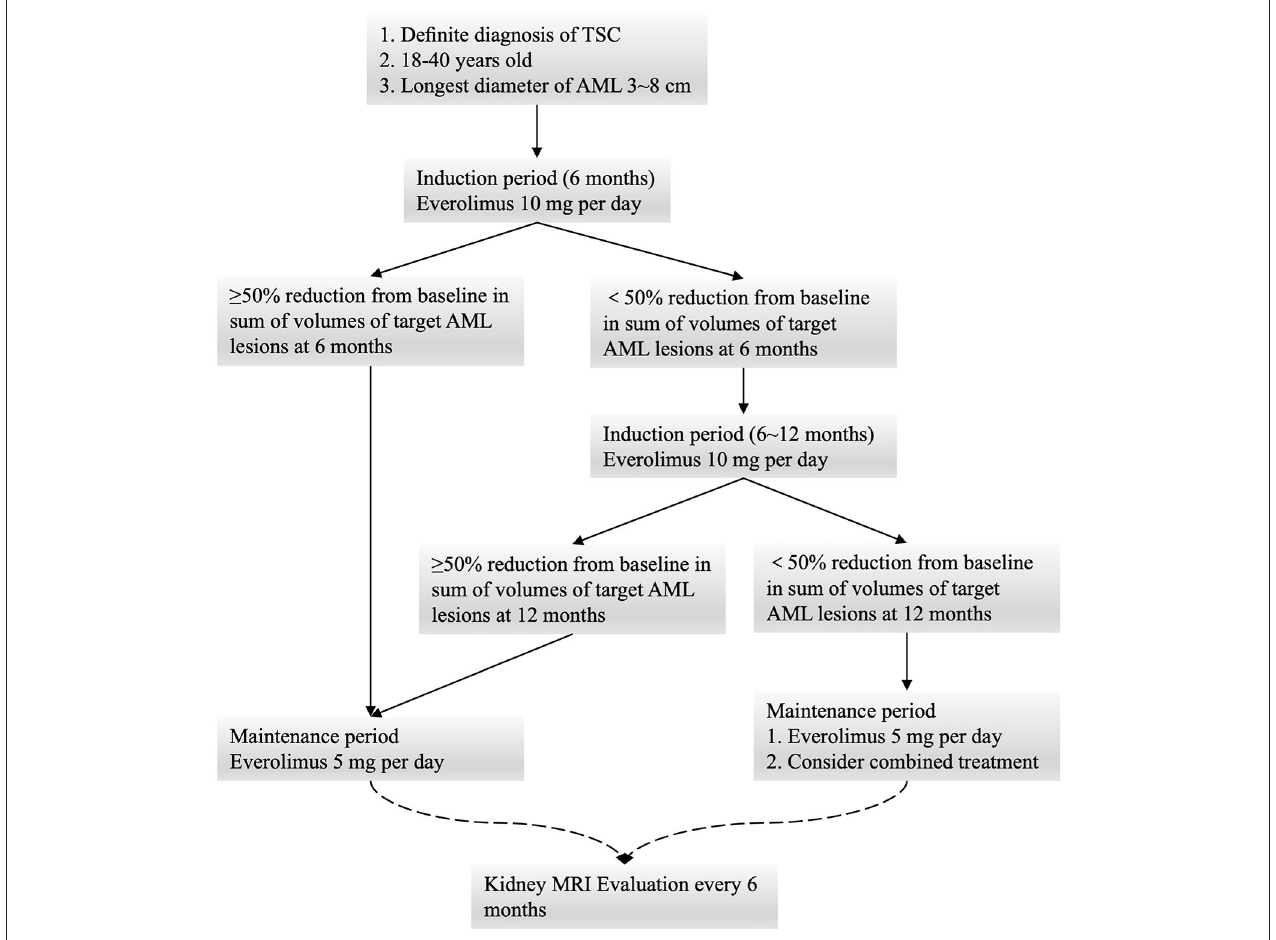
FIGURE 1 | Low-dose maintenance treatment schematic